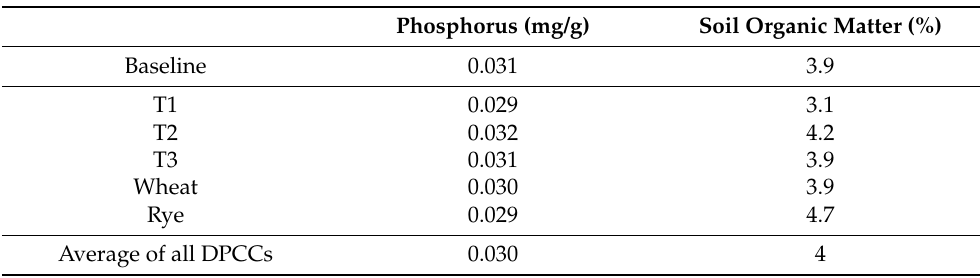
Table 3. Phosphorous levels (mg/g) in the field at the beginning of the experiment in September 2016 (baseline), and the levels in the soil following each crop at the conclusion of the experiment in September